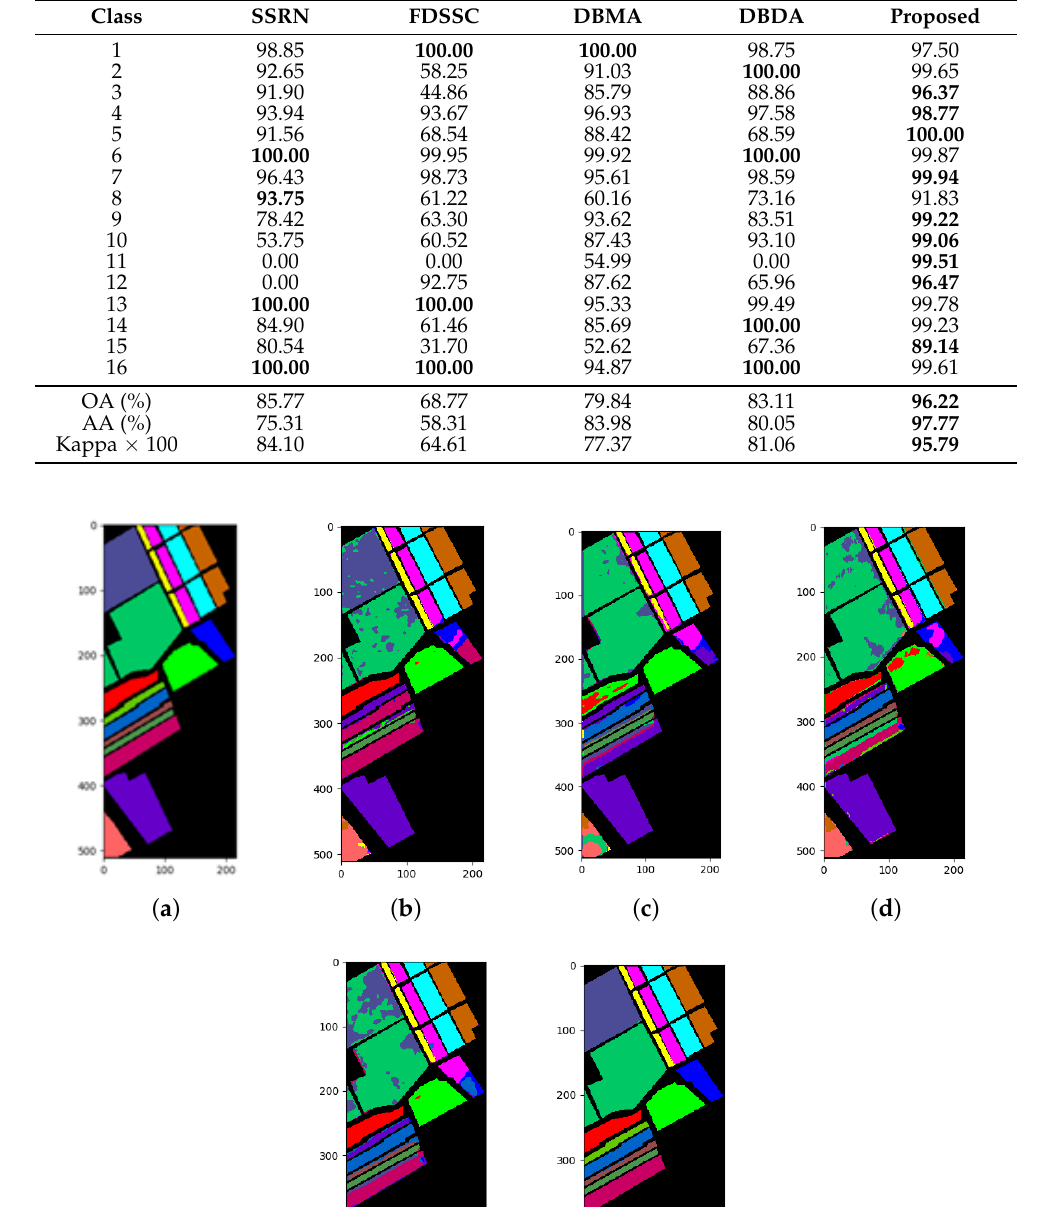
Table 7. Categorized results for the SA dataset.